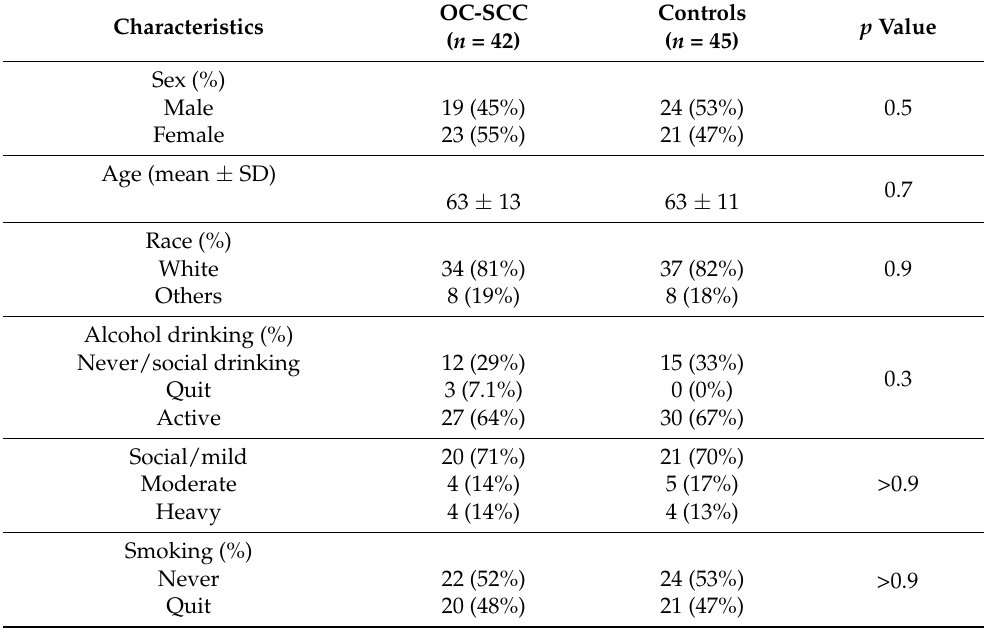
Table 1. Patient characteristics of nonsmoking OC-SCC patients and